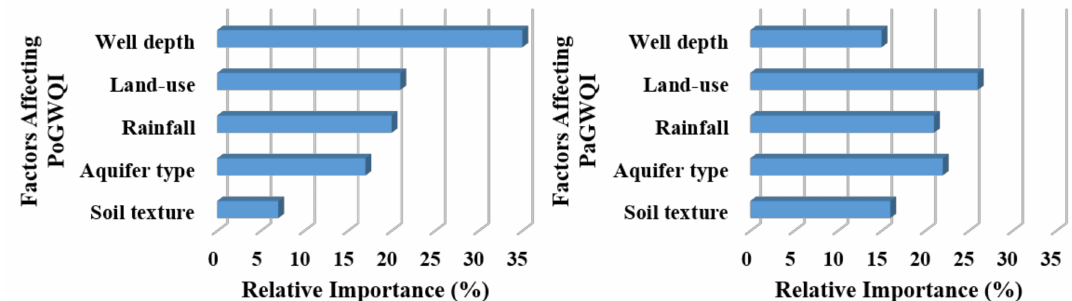
Figure 10. Relative importance analysis for the main factors affecting PoGWQI and